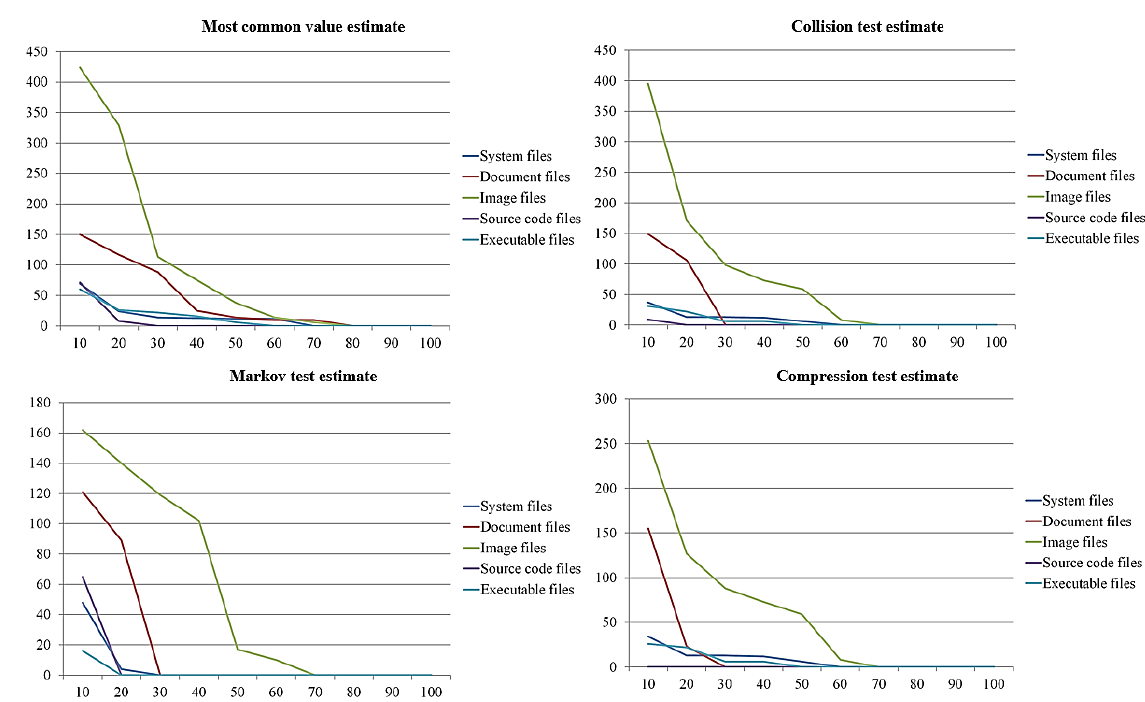
Figure 9. Total number of false positive files.